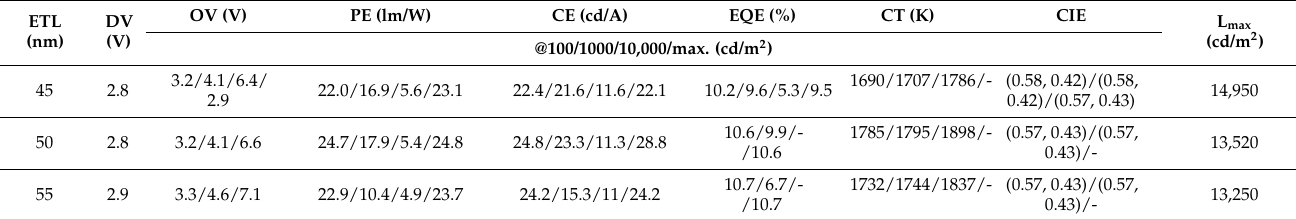
Figure 6. The studied BPMO- and CBP-based candlelight organic LEDs with (at 10 wt%) yellow and (at 10 wt%) orange-red emitter by varying electron transporting layer (ETL) thickness showing ( a ) the electroluminescent spectra, ( b ) variation of EQE with respect to luminance, ( c ) luminance-voltage-current density (L–V–J), ( d ) power efficacy-luminance-current-efficacy curve. The device with 55 nm thickness shows better performance among all. Table 3. Effects of ETL (TPBi) thickness on power efficacy (PE), current efficacy (CE), EQE, color-temperature (CT) of studied BPMO- and CBP-based candlelight organic LED using (at 10 wt%) yellow (PO-01) and orange-red (Ir(2-phq) 3 )